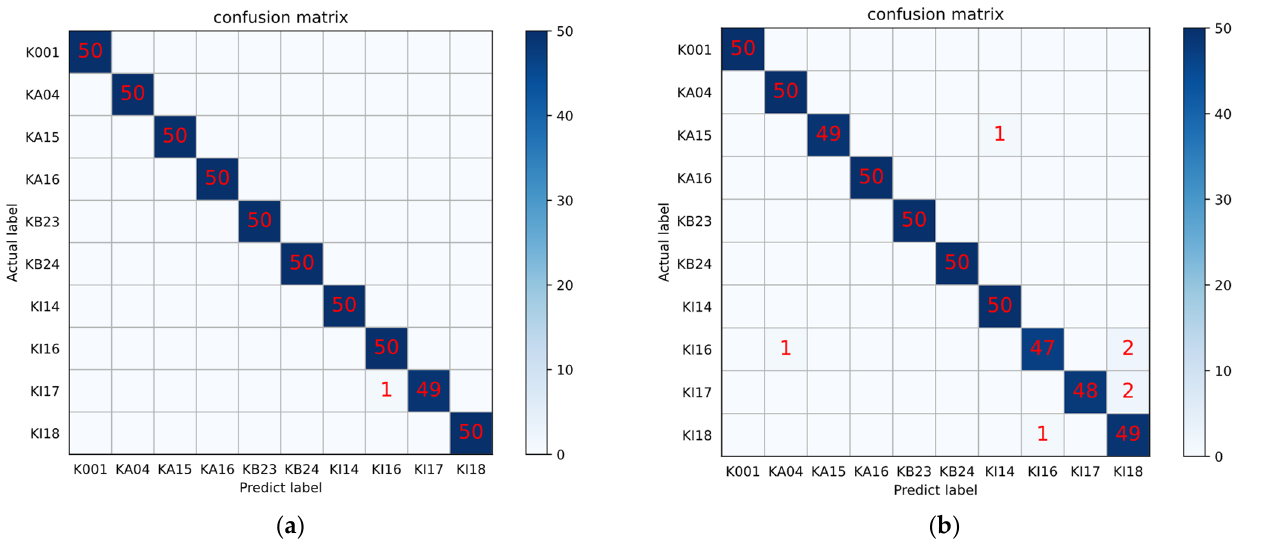
Figure 11. Confusion matrix of the two best-performing methods on dataset 2. ( a ) SMoCo; ( b ) labeled pretraining.